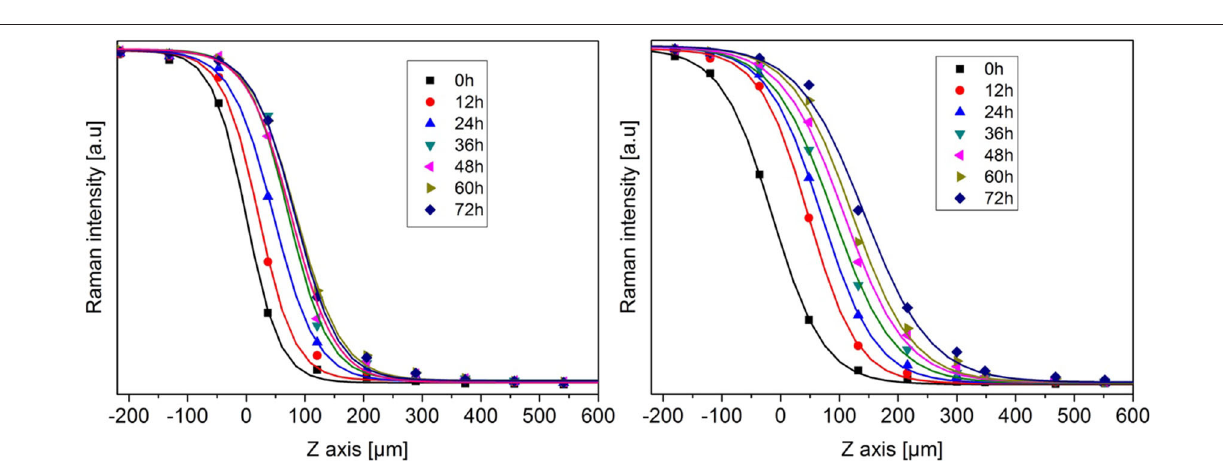
FIGURE 3 | Time evolution of the H 2 Raman intensity profiles for THF-H 2 (left) and THF-HClO 4 -H 2 (right) hydrates obtained at 270K and 200 bar. The continuous lines are the sigmoidal functions fitted on the experimental points (see text for